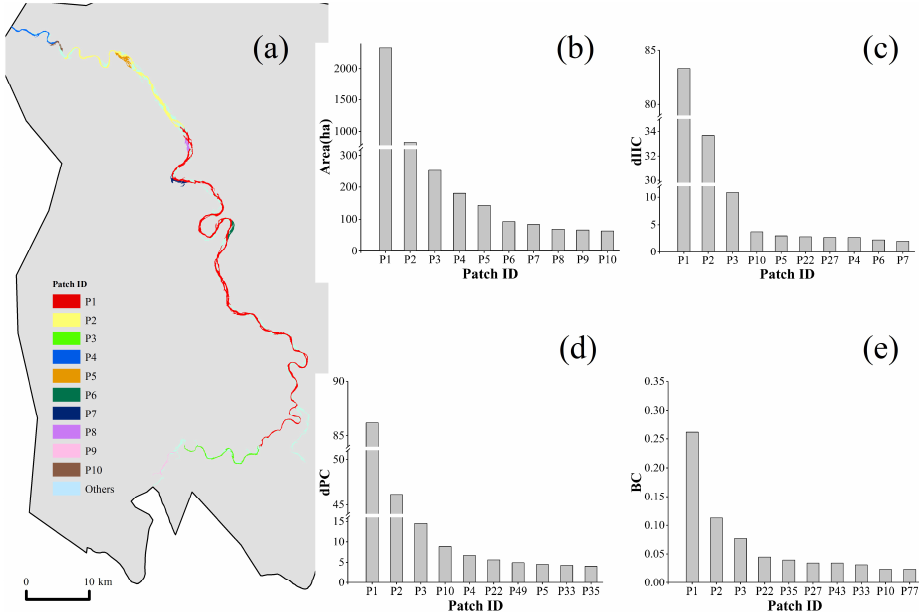
Figure 8. Statistics of different indices for the top 10 patches obtained from the results of connectivity modelling for 2019. ( a ) Distribution of patches, ( b ) Area of patches, ( c ) dIIC, ( d ) dPC, and ( e ) BC.